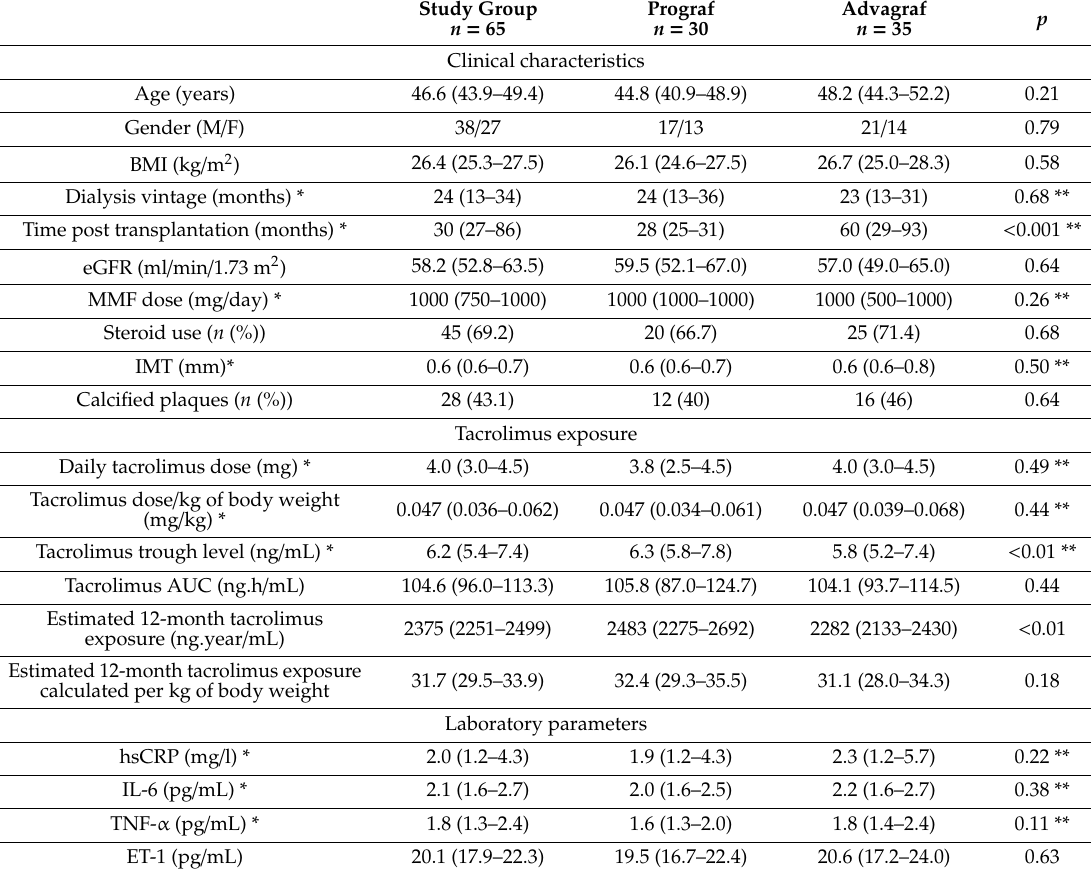
Table 1. The characteristics of kidney transplant recipients treated with two di ff erent tacrolimus